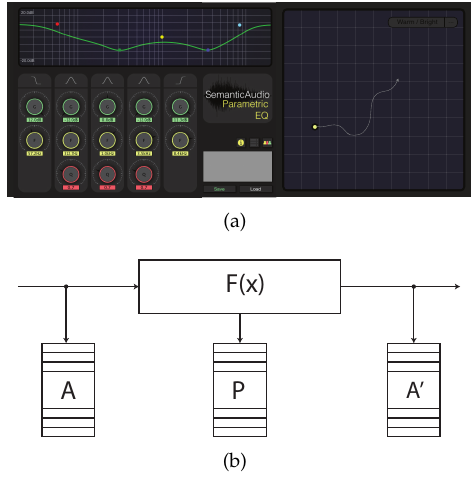
An overview of the Semantic Audio Feature Extraction (SAFE) equaliser and its feature extraction architecture. ( a ) The extended Semantic Audio Equalisation plug-in with the two-dimensional interface. To modify the brightness / warmth of an audio signal, a point is positioned in two-dimensional space; ( b ) The SAFE feature extraction process, where A represents the audio features captured before the effect is applied, A (cid:48) represents the features captured after the effect is applied, and P represents the parameter